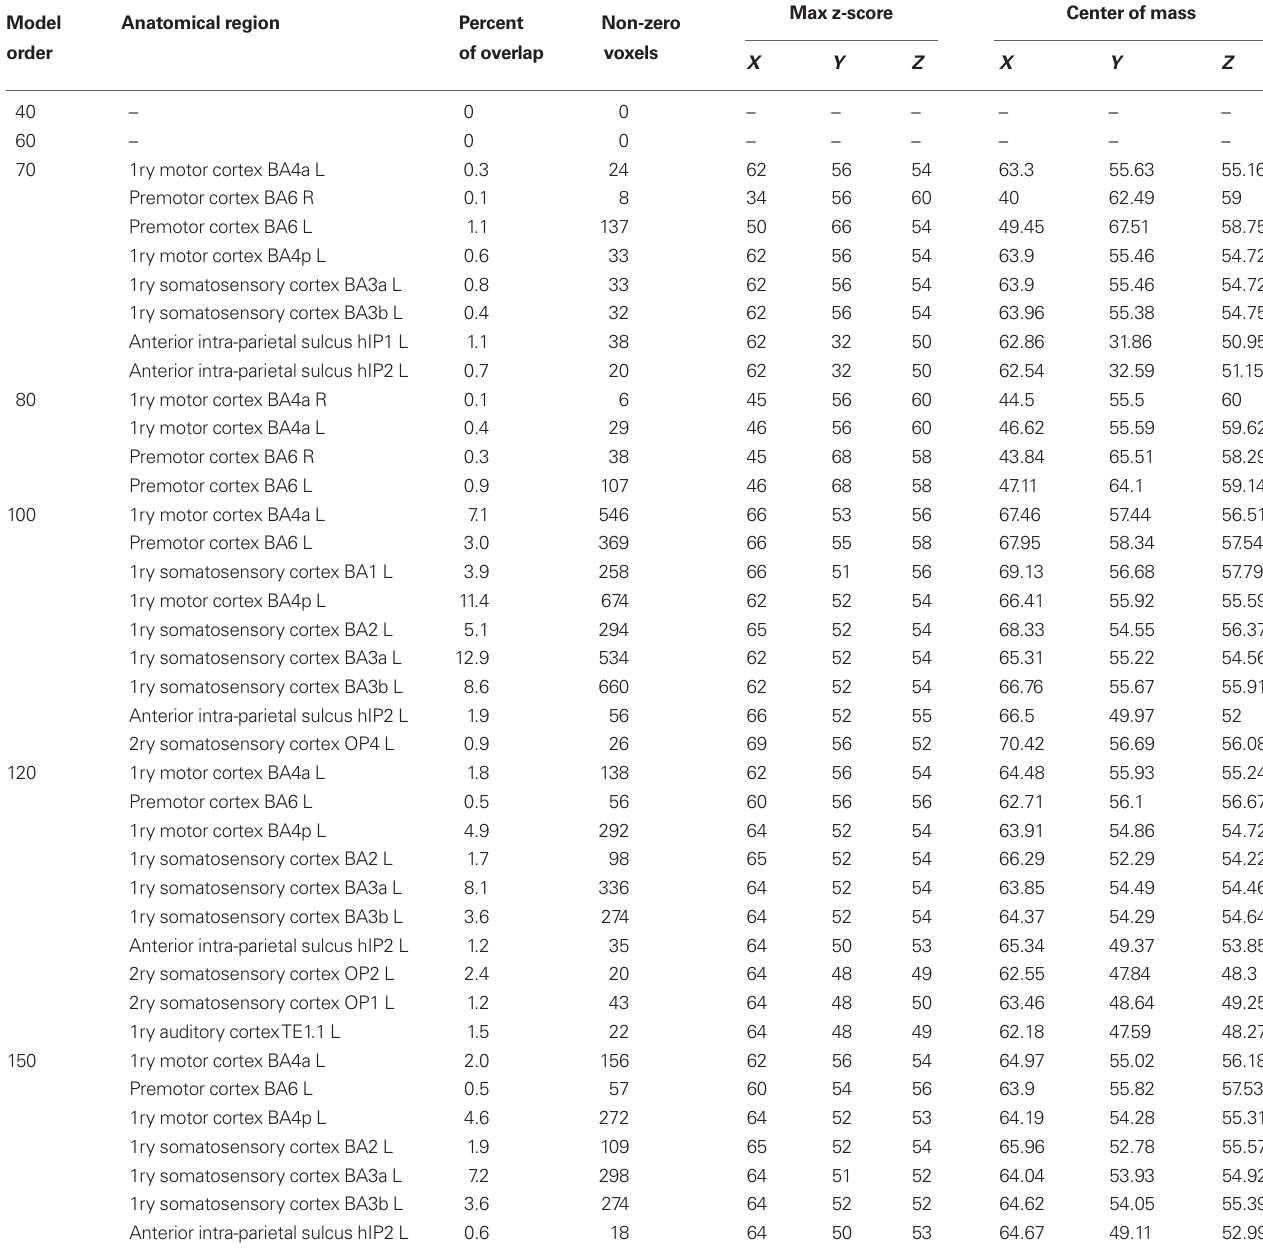
Table 4 | SAD functional connectivity differences in the motor cortex at all estimated ICA model